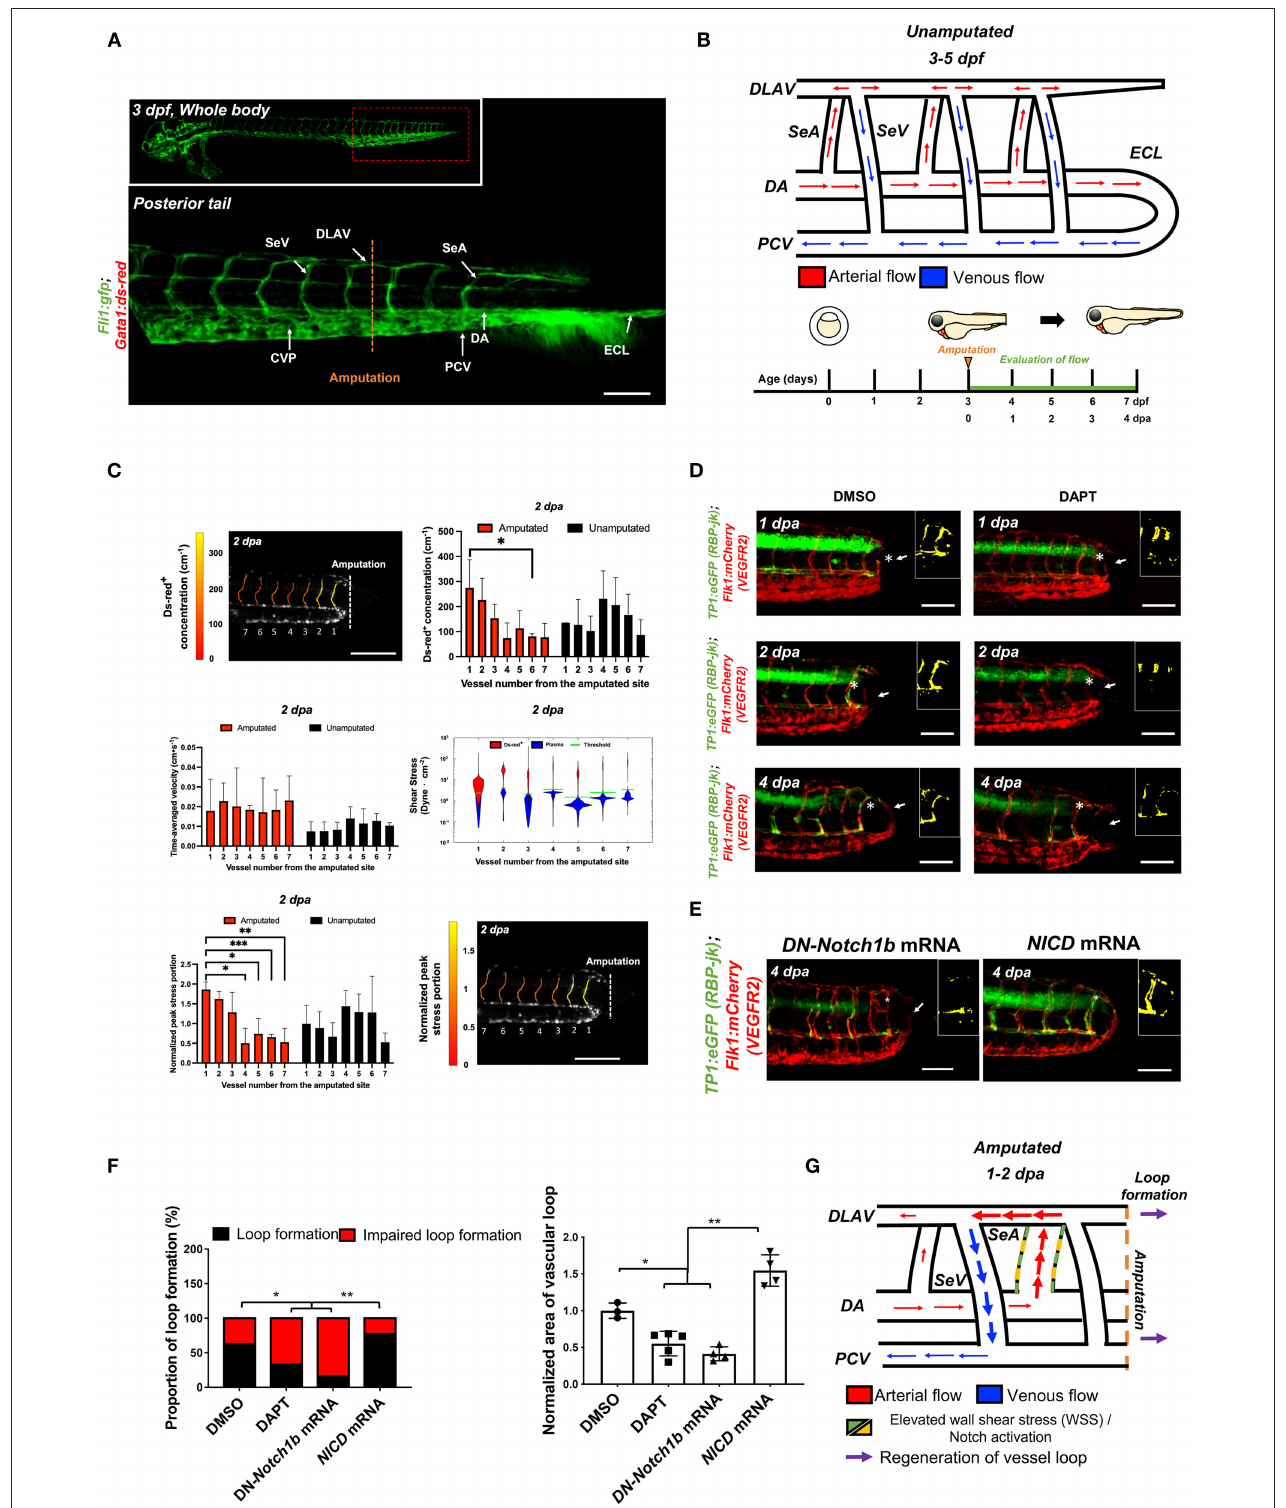
FIGURE 1 | Tail amputation increases peak wall shear stress (WSS) in the segmental artery (SeA) closest to the amputation site to promote Notch-mediated dorsal longitudinal anastomotic vessel-posterior cardinal vein (DLAV-PCV) loop formation. (A) Anatomy of tail vasculature in Tg(fli1:gfp; gata1:ds-red) embryos; Scale bar: 100 µ m. (B) Wiring diagram illustrate embryonic circulation in zebrafish tail. In the caudal vascular network, dorsal aorta (DA) forms an embryonic circulatory loop